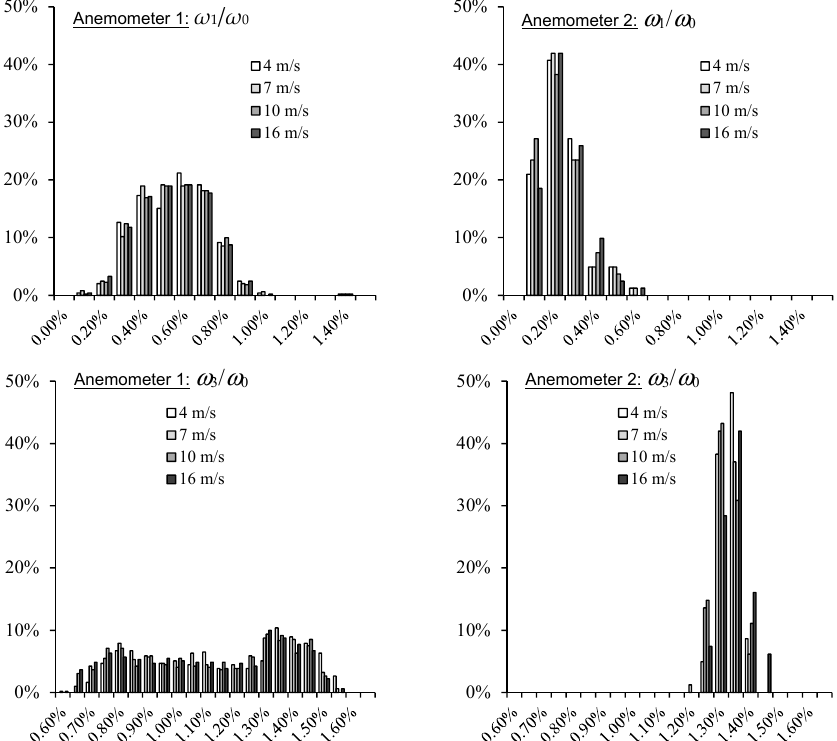
Figure 8. First and third harmonic terms, ω 1 / ω 0 and ω 3 / ω 0 , histograms from large series of two first class cup anemometers calibrated at Instituto Universitario de Microgravedad “Ignacio Da Riva” (IDR/UPM): Anemometer-1 and Anemometer-2.